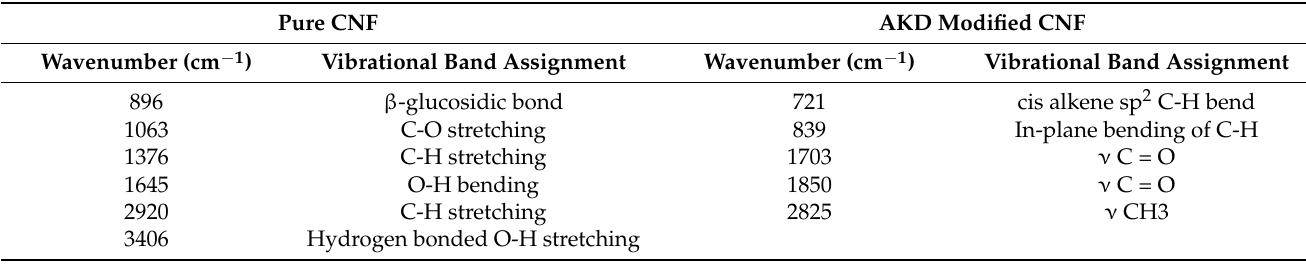
Table 1. Main Differences of FTIR Signals between CNF and